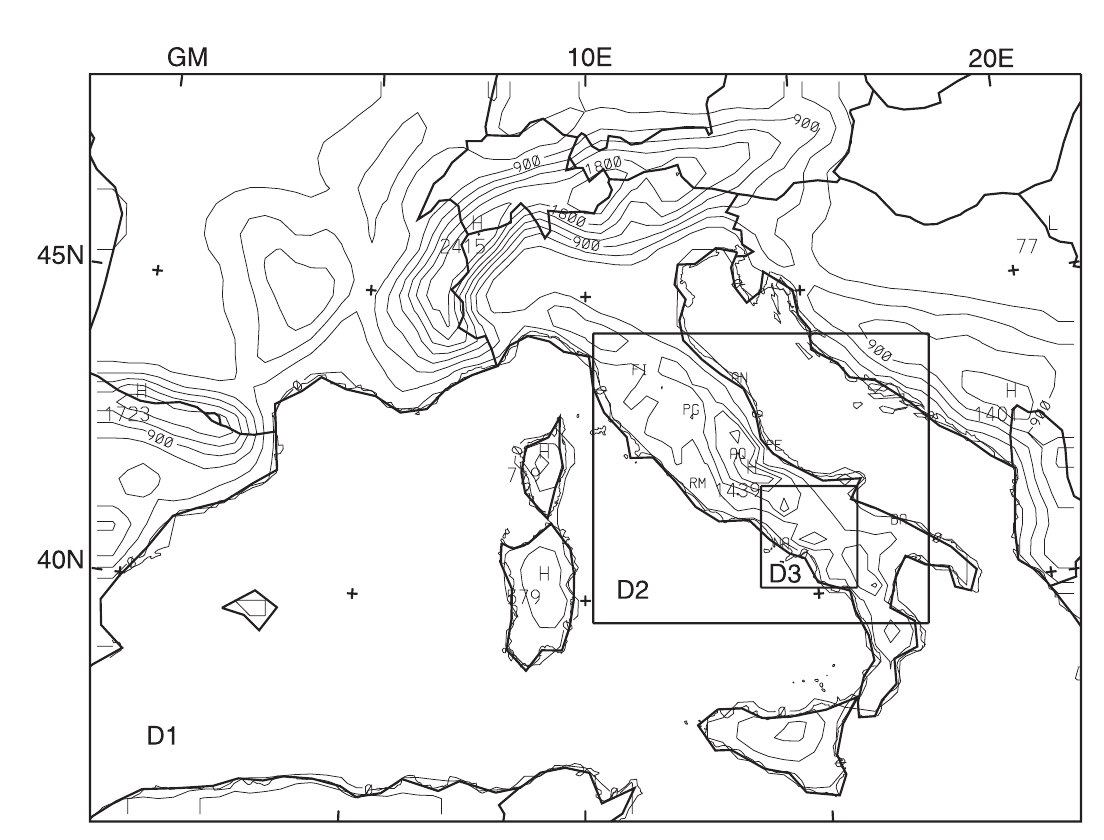
Fig. 1. Model domains: domain 1 has grid resolution of 27 km, domain 2 of 9 km and domain 3 of 3